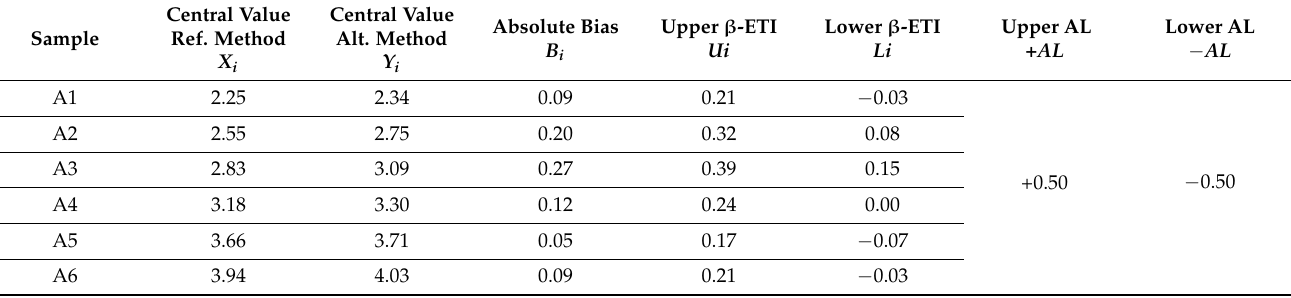
Table 6. Results of the accuracy profile study on chicken neck skin for C. jejuni [log 10 live counts/mL].